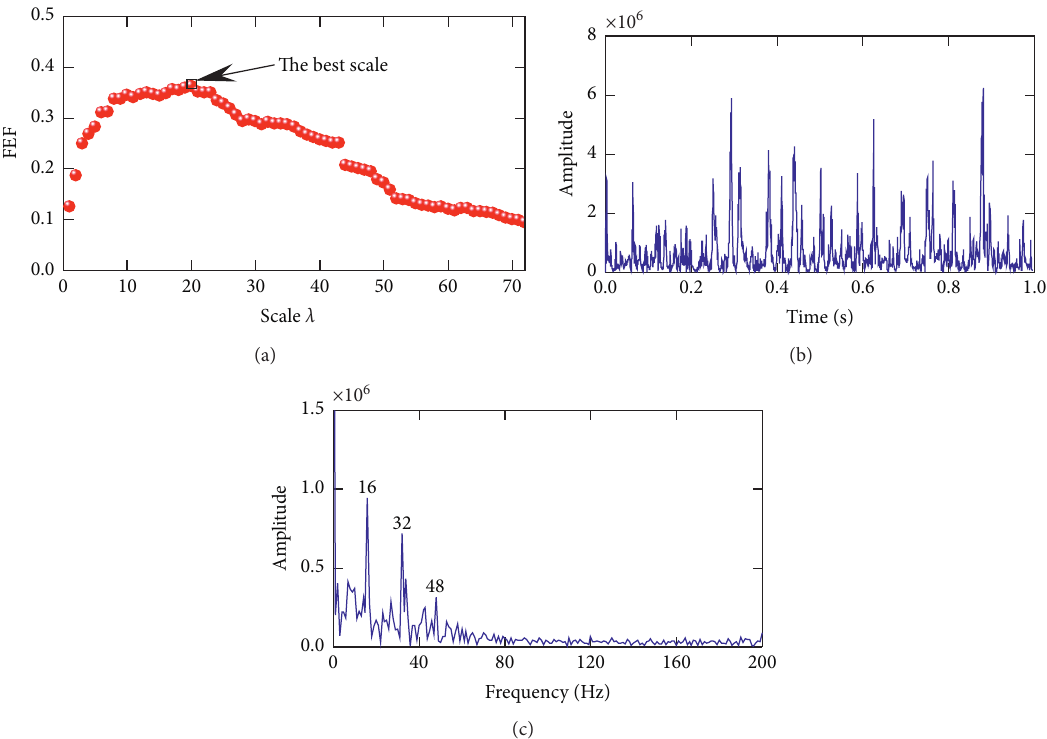
Figure 13: Case2: (a) correlation curve between FEF and scale λ ; (b) time-domain spectrum processed by the EMDF method; (c) frequency- domain spectrum processed by the EMDF